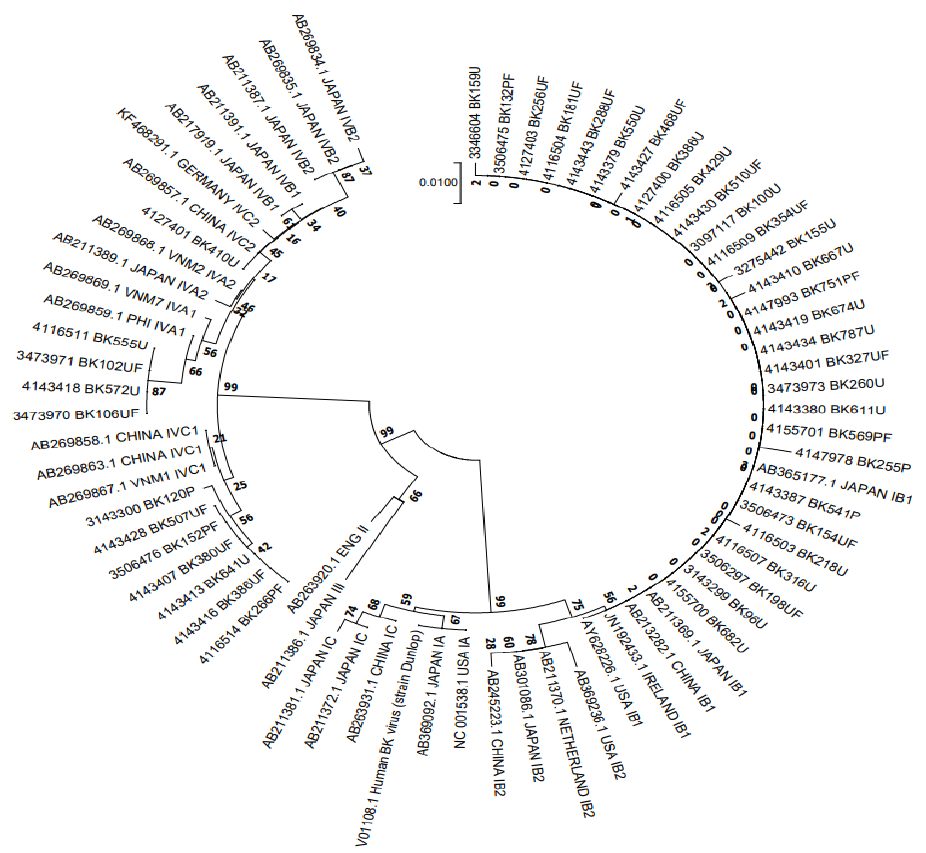
Figure 2. NJ phylogenetic tree clustering of 29 BKV-I and 12 BKV-IV polyomavirus sequences to determine subgroups ( n = 41).